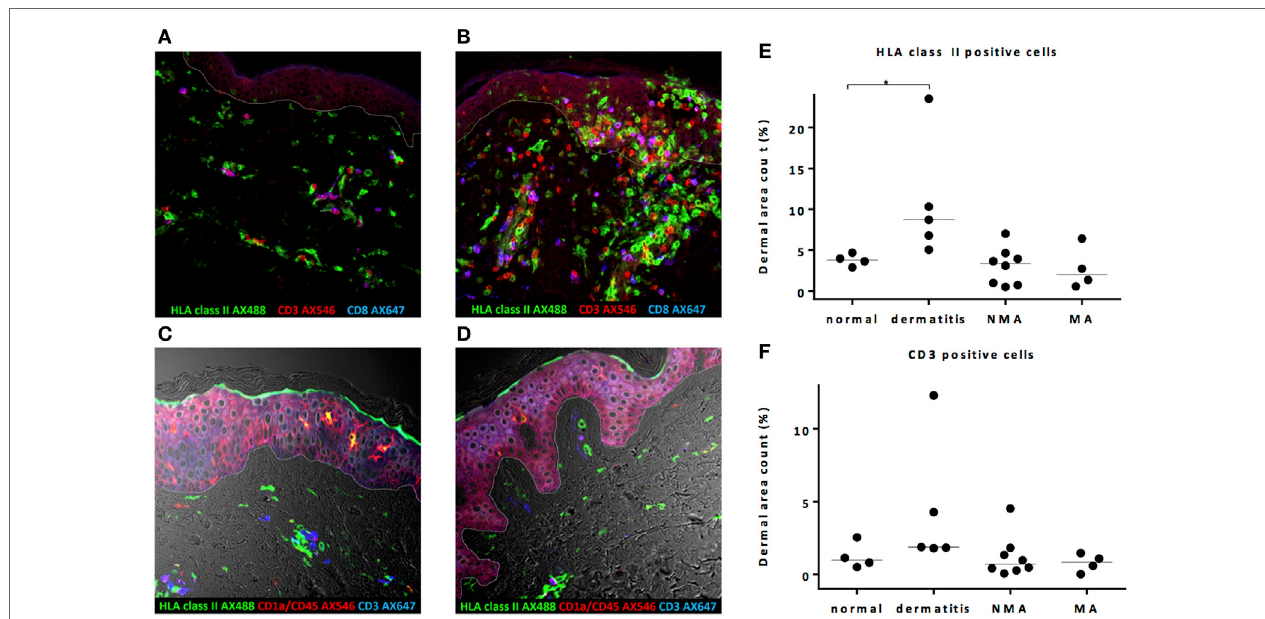
FigUre 1 | Pretransplant conditioning did not result in a pro-inflammatory environment in the skin at the time of transplantation. (a) In normal skin, HLA class II-expressing cells and also T-cells are present scattered over the whole dermal region. In the epidermal layer, HLA class II-expressing cells were observed sporadically. (B) In skin affected by dermatitis medicamentosa, dermal area count of HLA class II-expressing cells and T-cells is higher compared to normal skin. After non-myeloablative (NMA) conditioning (c) and myeloablative (MA) conditioning (D) , the presence of HLA class II-expressing cells and T-cells at the time of allogeneic stem cell transplantation (alloSCT) resembled the situation in normal skin. Dermal area counts with median were calculated for HLA class II-expressing cells (e) and CD3 T-cells (F) in skin biopsies of normal skin, skin at the time of alloSCT after NMA and MA conditioning, and skin affected by dermatitis medicamentosa. A significant difference was detected regarding HLA class II-expressing cells between normal skin and skin affected by dermatitis medicamentosa (Kruskal–Wallis test p = 0.019, post hoc Mann–Whitney U -test p = 0.016). White line demarks the border between dermis and